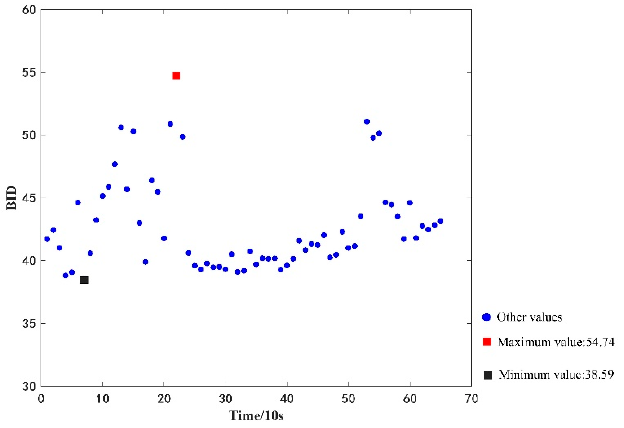
Figure 8. BID values of the faulty dataset.